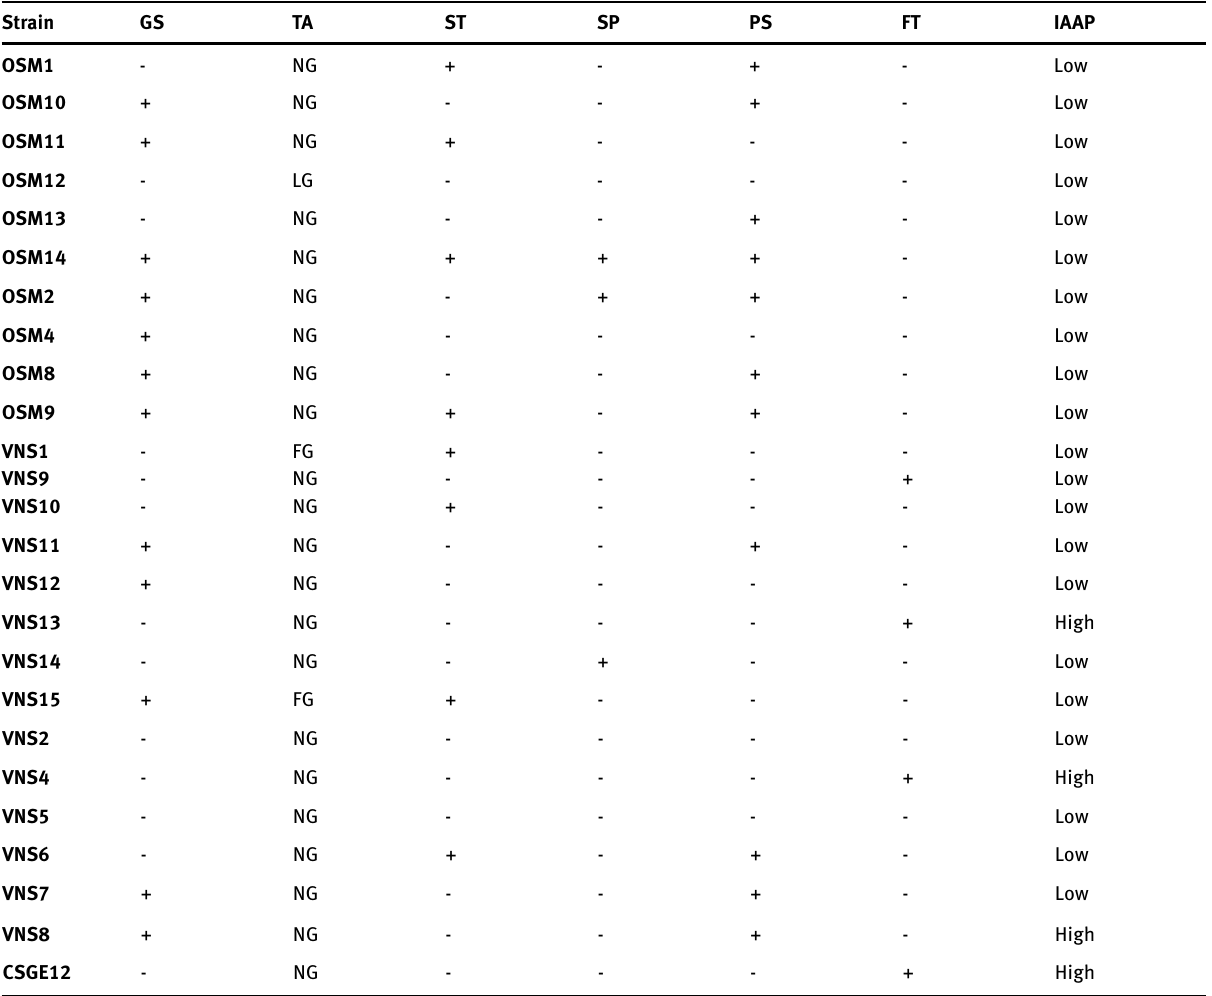
Table 1: Results of the tests applied to the 25 microorganisms found in both samples of soil